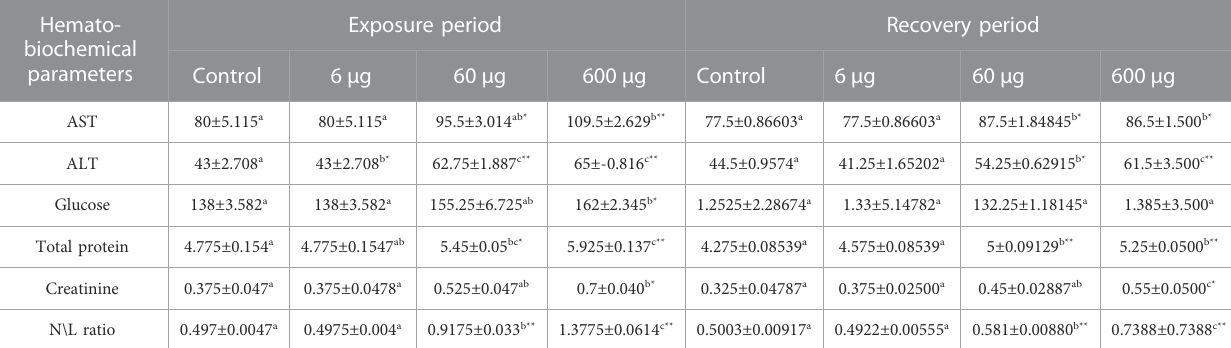
TABLE 4 Effect of 15 days of exposure to microplastics (MPs) and recovery on the biochemical parameters of the C57BL/6 murine model. Data are represented as means ± SE. Values with different superscript letters in the same row for each parameter are signi fi cantly different ( p < 0.05). Values of recovery period with * are signi fi cantly different from exposure